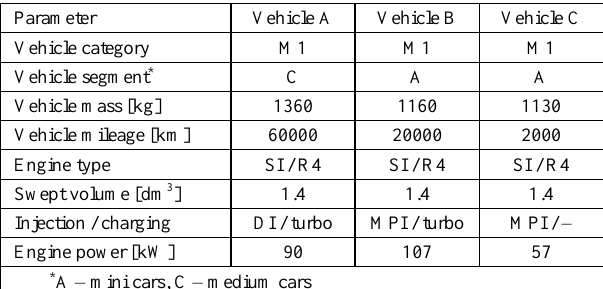
Table 1. Specification of tested vehicles